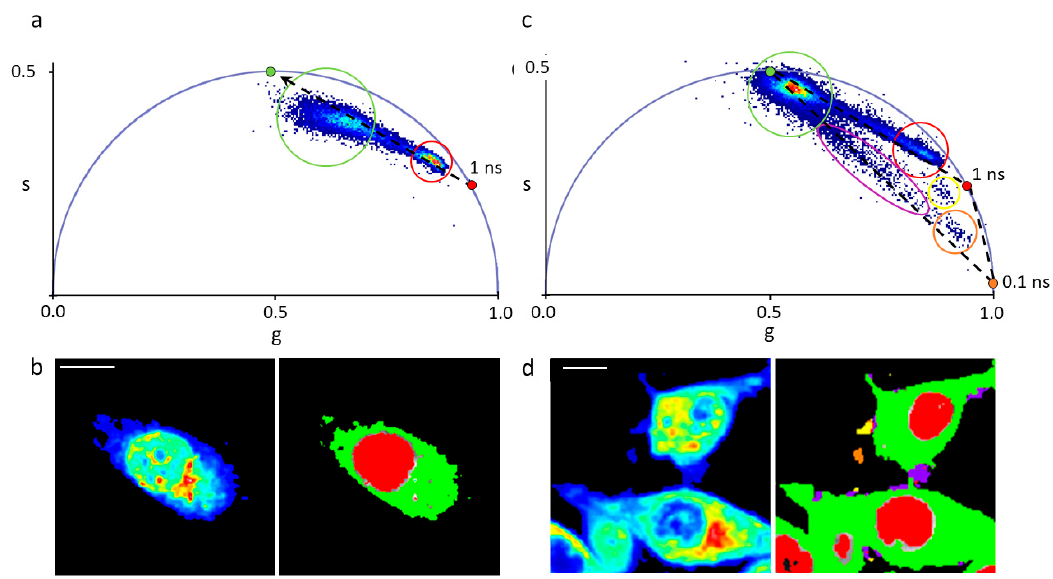
Figure 4. Phasor FLIM analysis of MDA-MB 231 cell exposed to DOX and GO-DOX. ( a ) Phasor representation of lifetimes measured in cells exposed to DOX. The phasor plot contains clouds of points that correspond to pixels with similar lifetime spectra. These clouds can be selected by specific regions of interest (ROIs). The green ROI, for instance, highlights the portion of pixels corresponding to DOX in the cytoplasm (see right panel in ‘b’, the cytoplasm is colored in green); the red ROI clearly identifies pixels corresponding to DOX in the nucleus (see right panel in ‘b’, the nucleus is colored in red); a dashed line is drawn across the phasor distribution and used to extrapolate the hypothetical position of a pure species on the universal circle (green point located at 4 ns) presumably corresponding to DOX associated to membranes. ( b ) Intensity (left) and lifetime (right) images of aMDA-MB 231 cell exposed to DOX (the same analyzed in (a)). The lifetime image is colored according to the ROIs in (a). ( c , d ) Same as before but for MDA-MB 2311 cells exposed to GO-DOX. Please note that the phasor-FLIM signature of cytoplasmic (green cursor in ‘c’, green pixels in ‘d’) and nuclear DOX signals (red cursor in ‘c’, red pixels in ‘d’) show clear similarity to that obtained for free DOX. By contrast, as expected, additional signals are present here, which are absent in cells treated with free DOX. In particular, as highlighted by the violet, orange and yellow cursors in ‘c’ (and pixels of the same color in ‘d’) there are micrometric patches, mostly associated with cell membranes, with variable amounts of the nude carrier (GO) and the released drug (both free or associated to cellular membranes). Scale bars: 10 μ m.